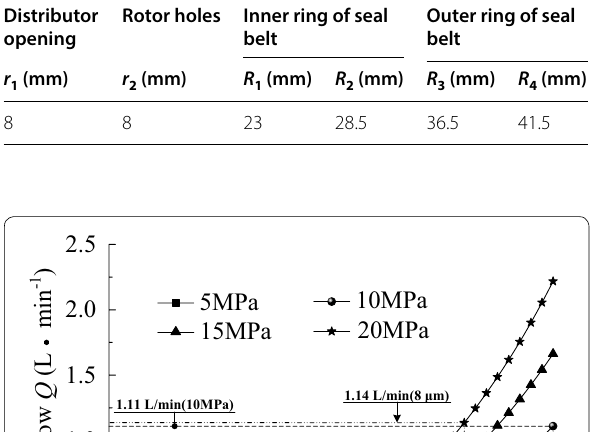
Table 1 Design parameters of port plate pairs Distributor Rotor holes Inner ring of seal opening belt